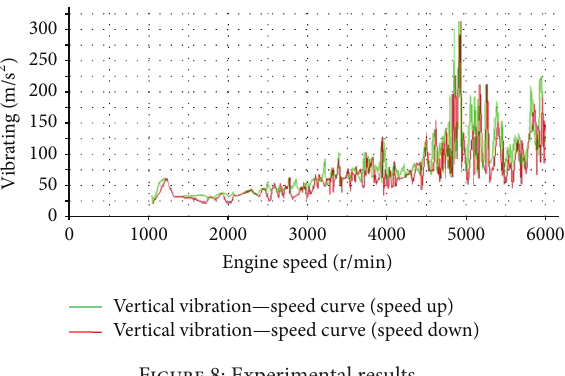
Figure 8: Experimental results.